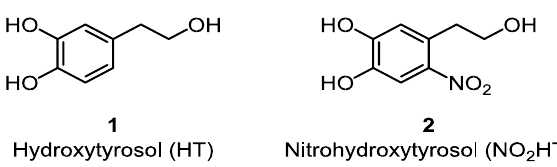
Figure 1. Chemical structures of parent compounds ( 1 ) and ( 2 ).